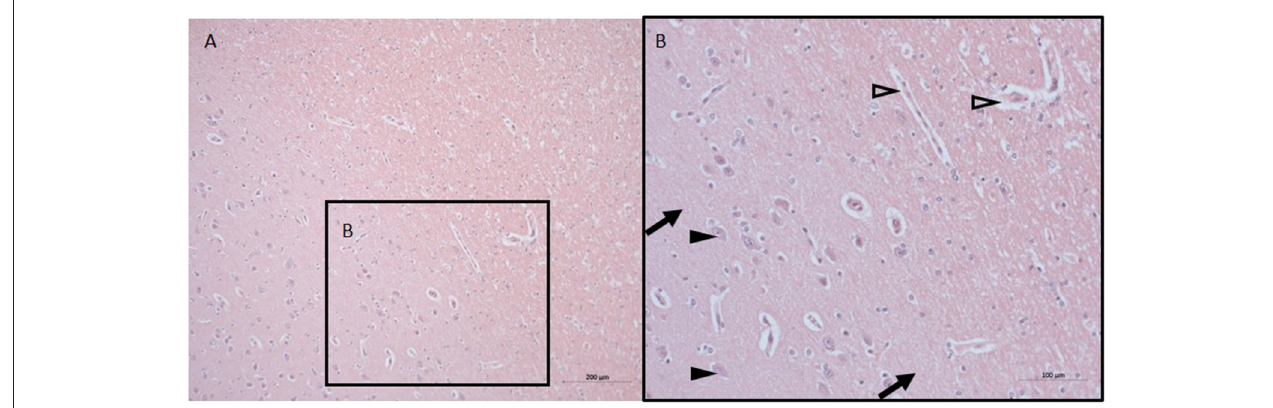
FIGURE 1 | Neuro-histopathological evaluation. Exemplary pictures of HE staining in cortico-subcortical brain tissue with signs of minor perivascular edema in sections from the same macroscopic sectional plane as the PVN at 10X (A) and 20X (B) . Black arrows point to intact parenchyma, black arrowheads depict nerve cells, open arrowheads point to minor perivascular edema. HE, Hematoxylin and eosin; PVN, paraventricular